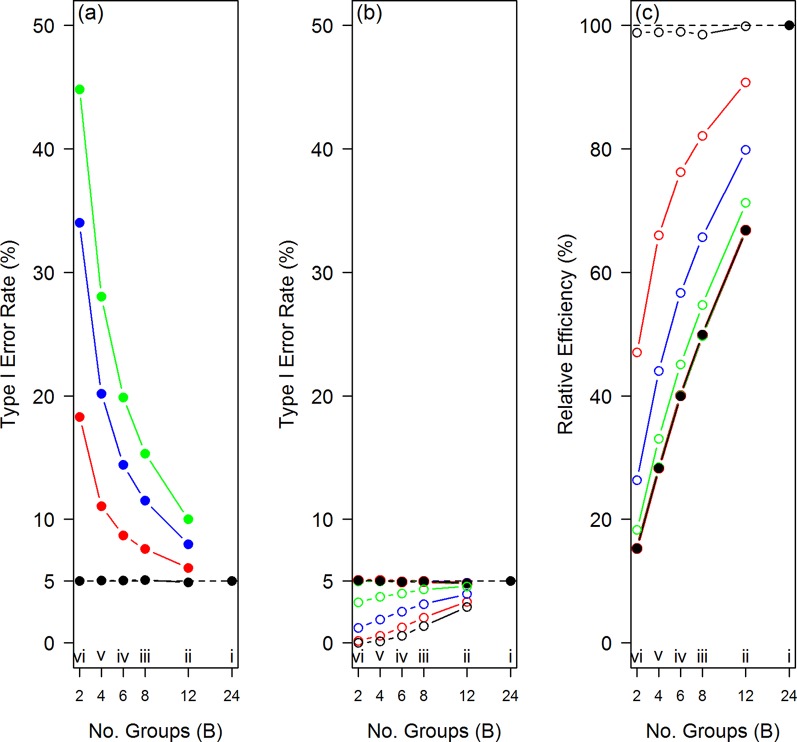
Naive use of a conventional t-test on correlated (grouped by subject) data, ρ = 0 (black circle ), ρ = 0.2 (red circle) ρ = 0.5 (blue circle) and ρ = 0.8 (green circle), inflates the type I error rate (set at 5%).(a). The type I error rate can be controlled to the required level by randomly selecting a single measurement for each subject, ρ = 0 (black circle), ρ = 0.2 (red circle), ρ = 0.5 (blue circle) and ρ = 0.8 (green circle), or made conservative (≤5%) by taking the mean of the measurements for each subject, ρ = 0 (black open circle), ρ = 0.2 (red open circle), ρ = 0.5 (blue open circle) and ρ = 0.8 (green open circle) (b). The relative efficiency of treatment effect estimates declines as the number of clusters become smaller and is always higher for the mean than the randomly selected single measurement strategy (c). The scenarios (i) – (vi) are as described in the text.